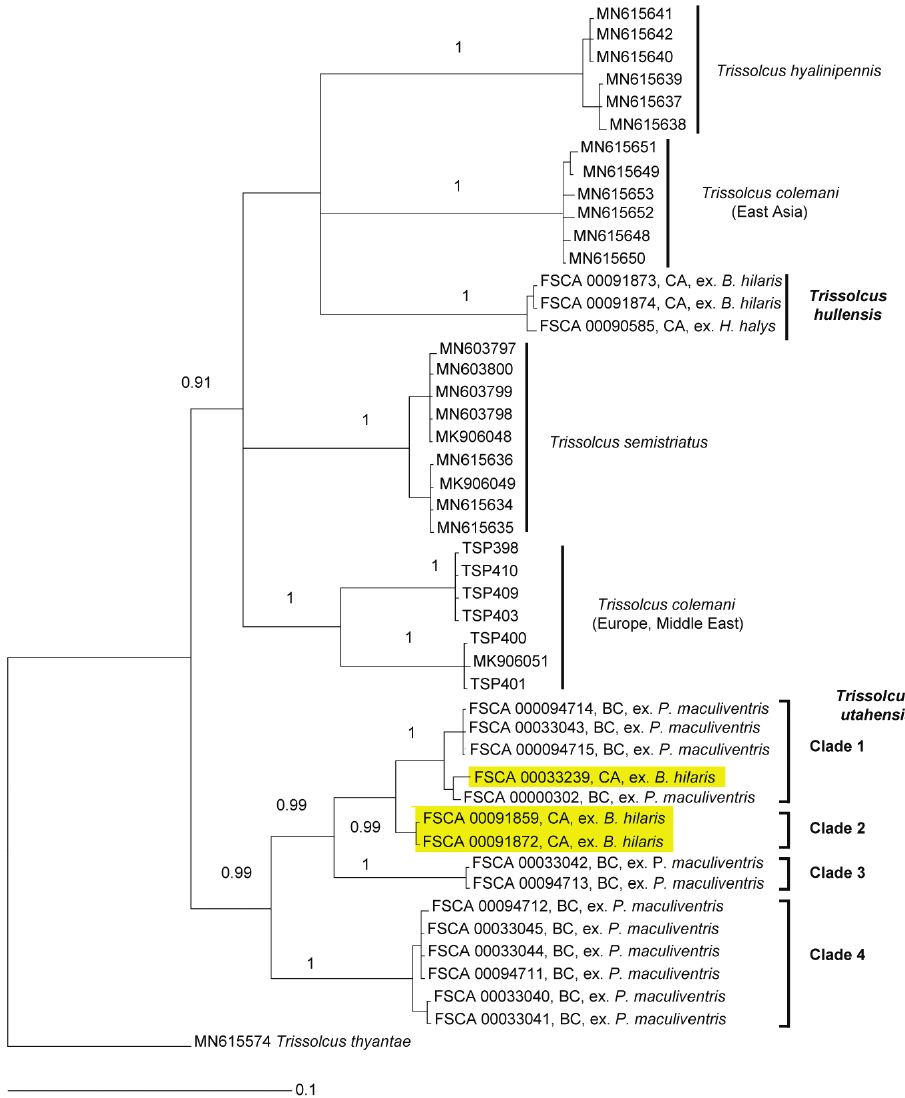
Figure 2. The Bayesian 50% majority rule consensus tree inferred from the 56 CO1 sequences of the six Trissolcus species including T. hullensis and T. utahensis . Only posterior probabilities >90% are indicated on the nodes. The tree is rooted with the outgroup Trissolcus thyantae (GenBank MN615574). The scale bar corresponds to 0.1 estimated substitutions per